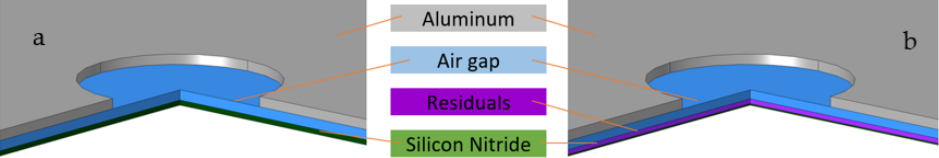
Figure 8. Designed and produced sizes of mirrors. ( a ) Designed mirrors: radius 35/45 µ m, silicon nitride thickness = 200 nm, no HF residuals; ( b ) Fabricated mirrors: radius 37/42 µ m, silicon nitride thickness = 60 nm, residuals height = 180 nm.